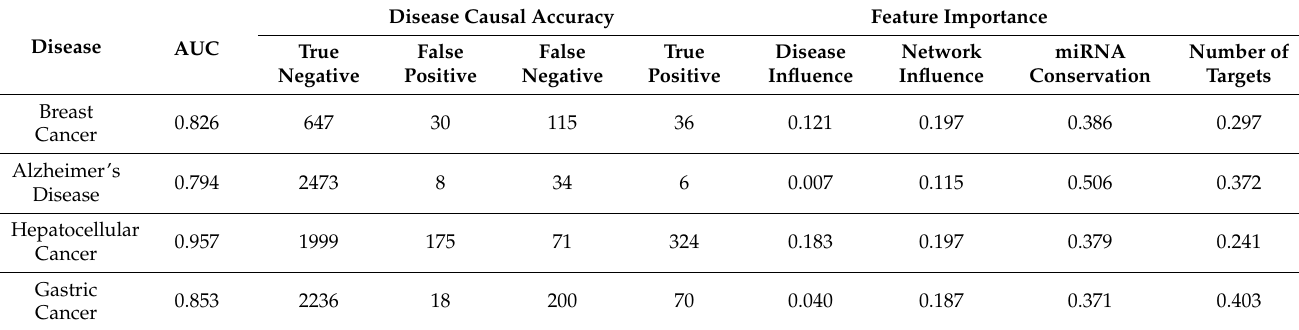
Table 2. Validation Metrics for each Disease Dataset across 100 random train/test splits.